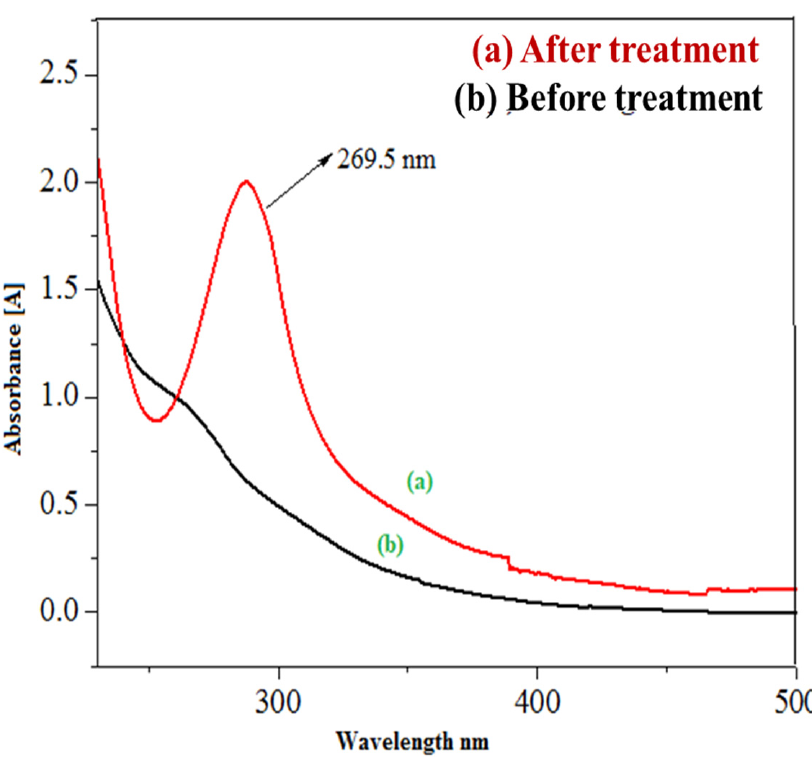
Figure 11. UV/Vis absorbance spectra of ( a ) as-fabricated imidacloprid sample and ( b ) sample of imidacloprid treated with basic prewetted nanocalcite (pH 11).